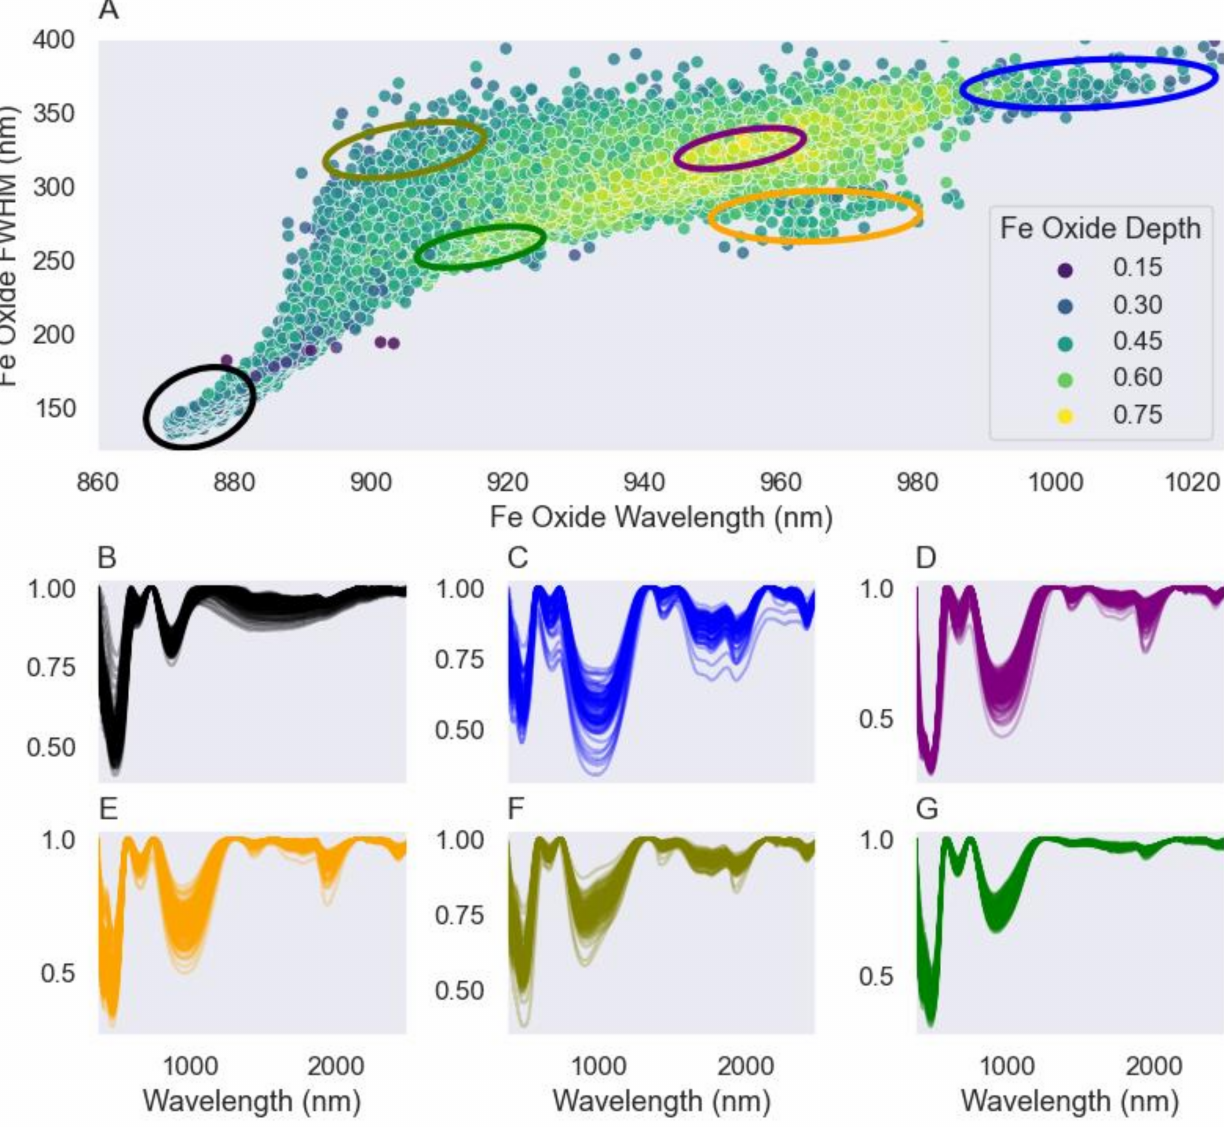
Figure 4. The iron boomerang for the diamond core-only dataset (Core 1) with SWIR masking in place and selecting several key regions of interest (ROI) is shown in ( A ) and coloured by the Fe oxide depth. Figure ( B – G ) show the hull-corrected spectra. ( B ) is the left most portion of the iron boomerang comprised of hematite samples. ( C ) and located at the right hand most side of the iron boomerang are primarily vitreous goethite. ( D ) represents a region of mixed ochreous and vitreous goethite. ( E ) is generally purer ochreous goethite and does not exhibit the drop off observed in ( C ) and ( D ) from approximately 1300 nm. ( F , G ), respectively, show mixtures of hematite and goethite with at least two different goethite types (vitreous and ochreous,